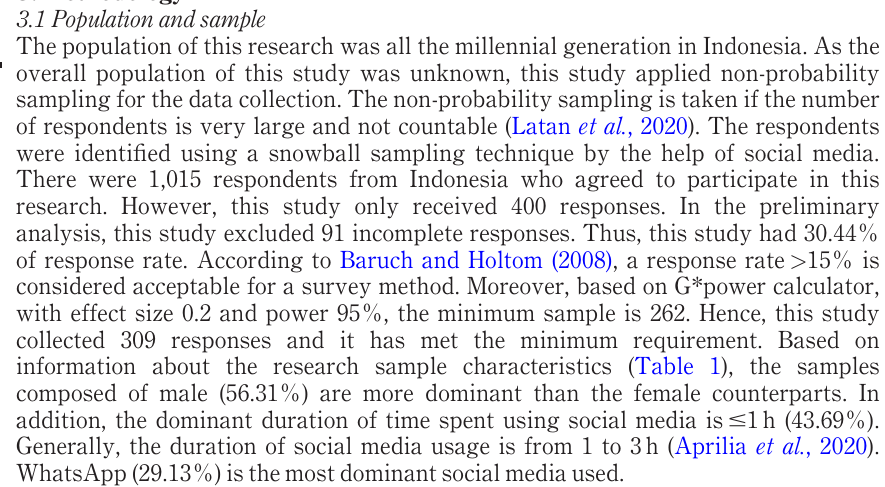
Figure 1. Proposed research model